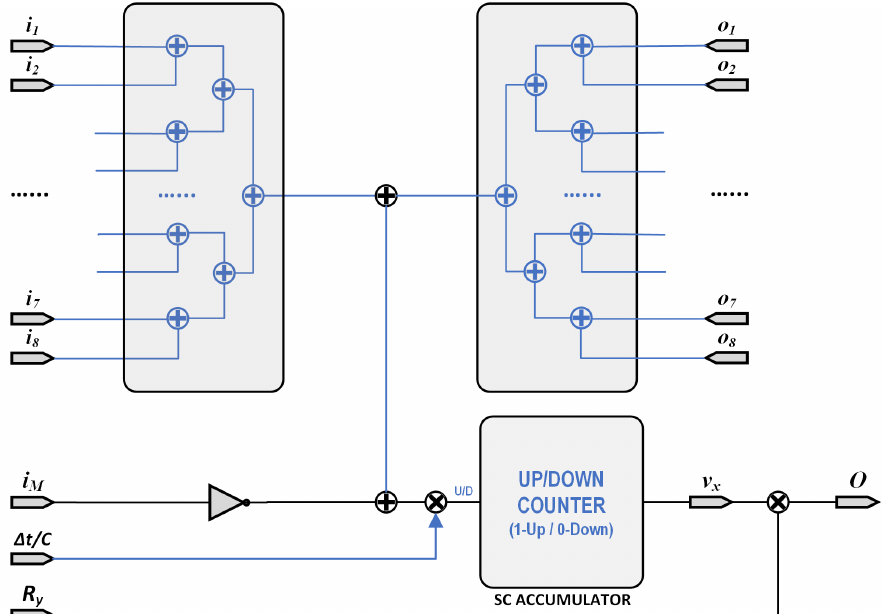
Figure 7. Stochastic Computing Circuit implementation of the M-CNN processing element C ( i , j ) as in Figure